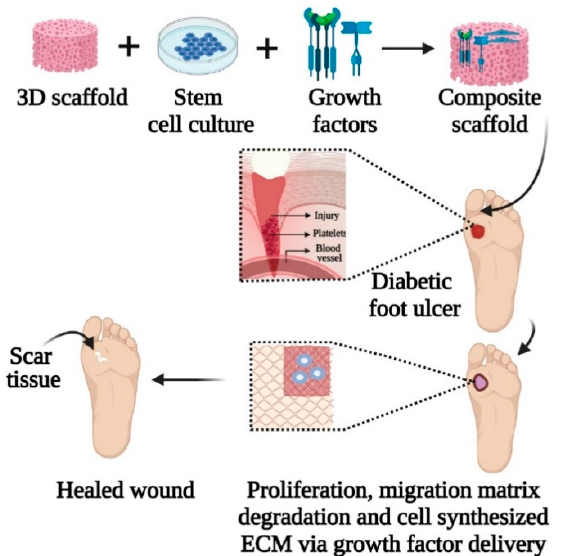
Figure 4. Biomaterial and growth factor incorporated stem cell therapy in diabetic foot ulcer treatment. Table 5. Combined application of biomaterials with stem cells in various wound healing treatments. Biomaterials Used